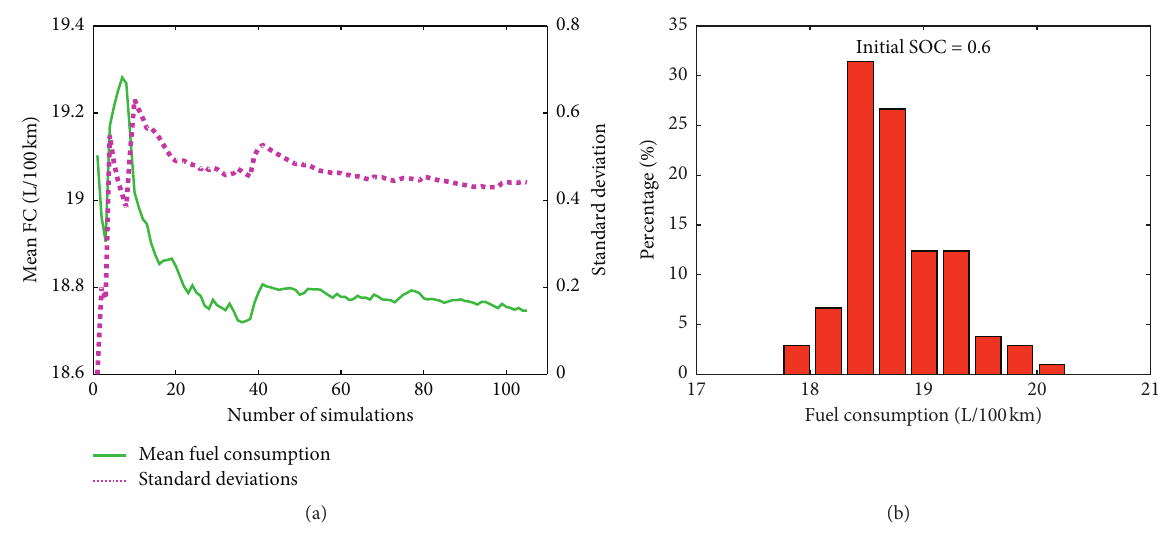
Figure 26: Mean FC, std. dev., and FC distribution for the measured data (initial SOC � 0.6). (a) Mean FC and std. dev and (b) distribution of the